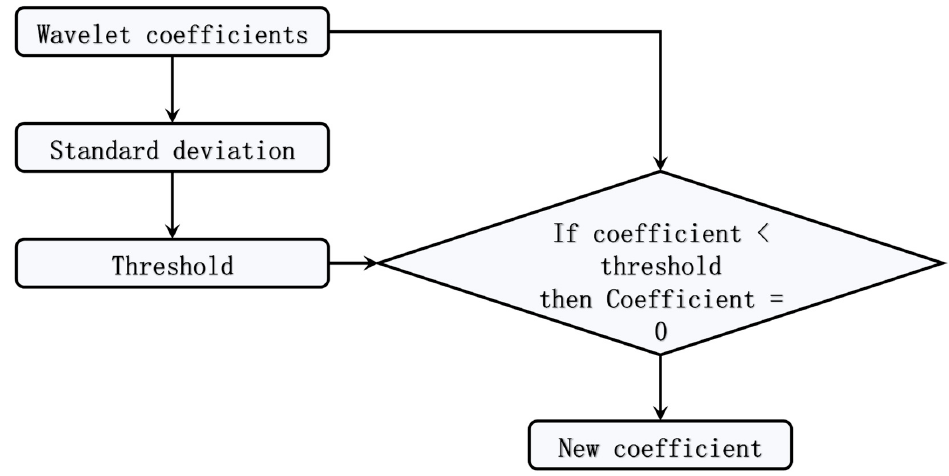
Figure 5. Hard threshold function working process.